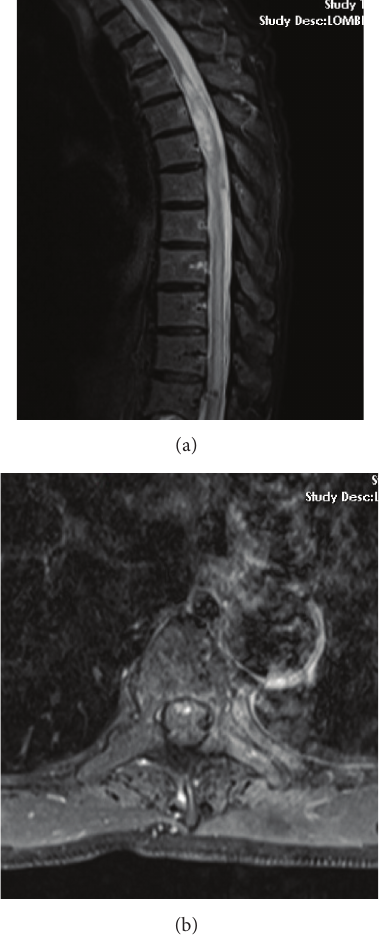
Figure 2: Magnetic resonance imaging scans revealed intramed- ullary hematoma and syrinx cavity.